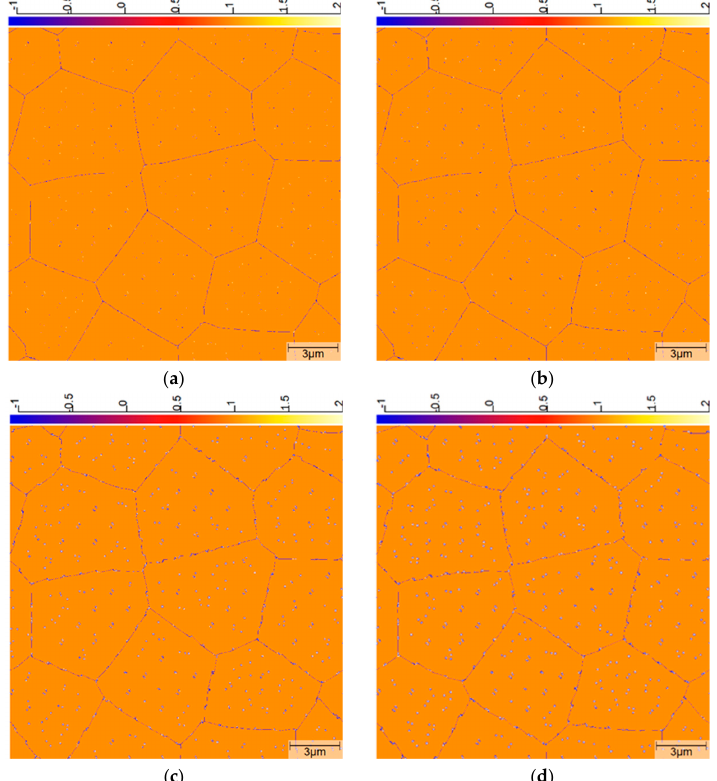
Figure 13. Spatial distribution of precipitates. The left column depicts the ternary system. Al-0.9Mg-0.6Si and the right column the Al-1.0Mg-1.1Si. Cases ( a , b ) are for the 180 °C-8 h simulation, while cases ( c , d ) for the 200 °C-8 h simulation. In the colour scale, number 1 depicts the matrix phase, number 2 depicts precipitates, while number 1 is attributed to the interfaces.